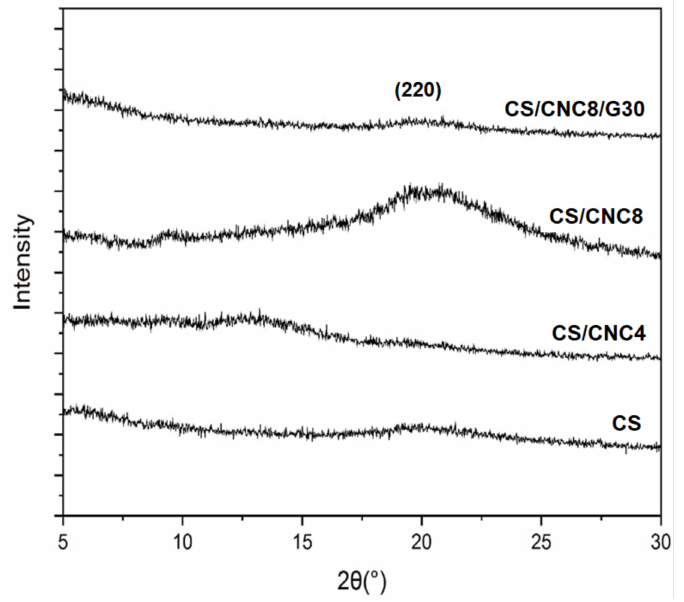
Figure 1. X-ray diffraction (XRD) patterns of chitosan and its bio-composite